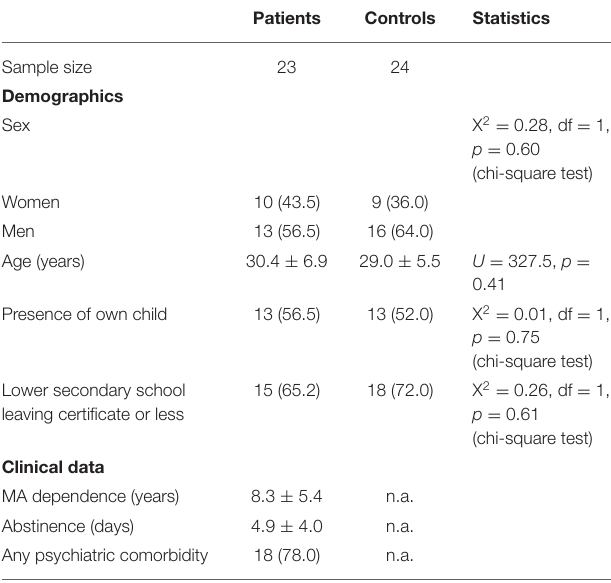
TABLE 1 | Sociodemographic and clinical data of